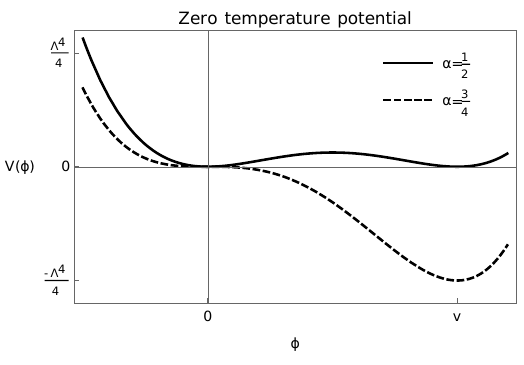
Figure 1 . The potential (2.7) at T = 0 for the two limiting values of the parameter (cid:11) . barrier between the vacua (as the zero temperature mass term changes sign), see (cid:12)gure 1. Of course, (cid:12)nite temperature corrections may allow for a higher value of (cid:11) , as